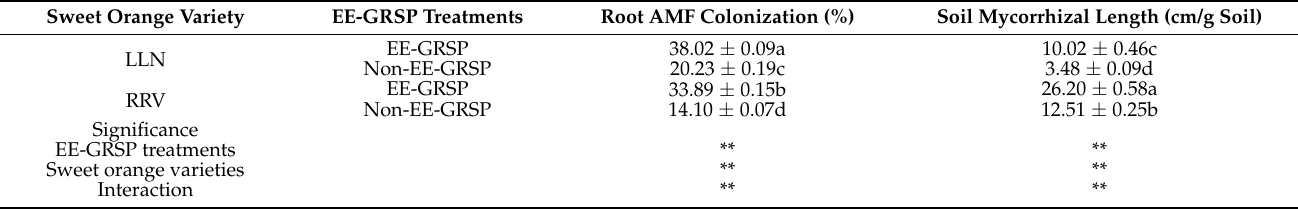
Table 1. Application response of exogenous EE-GRSP on root mycorrhizal colonization and mycorrhizal length within the mycorrhizosphere of late-ripening sweet oranges grafted on trifoliate orange. Sweet Orange